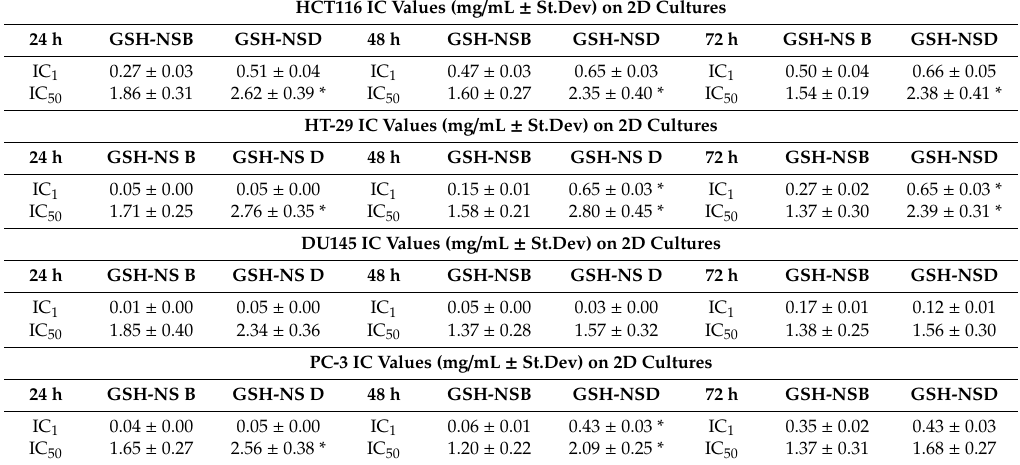
Statistically significant difference between the two nanosponge formulations: * p < 0.05.